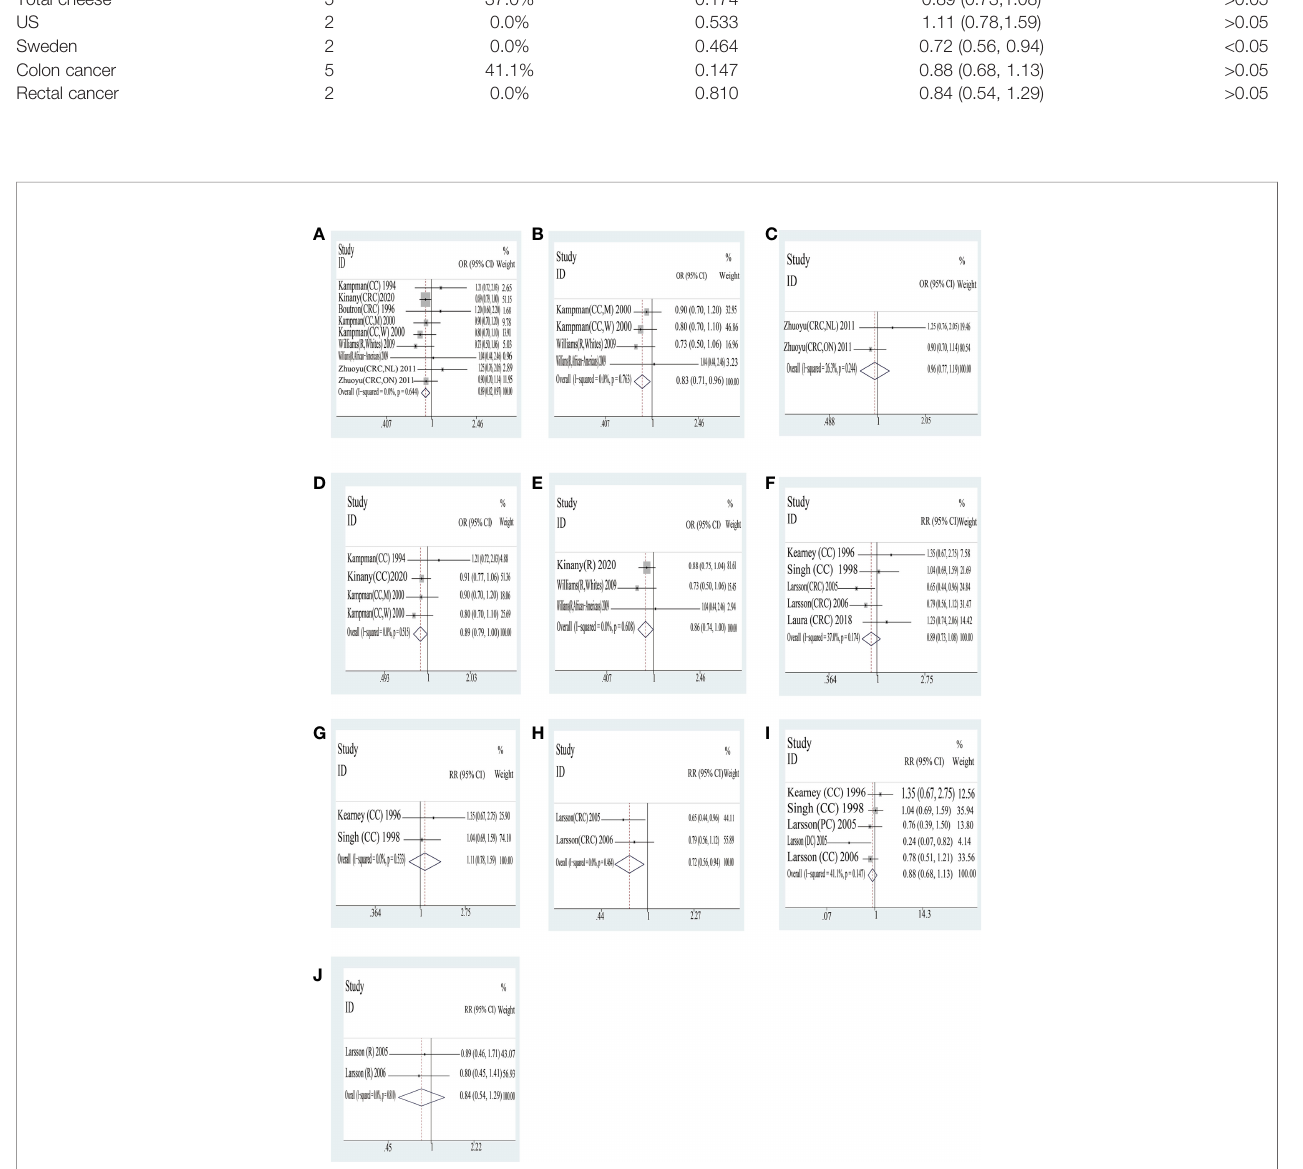
FIGURE 3 | Cheese: forest plot of case – control studies (A – E) and cohort studies (F – J) in yogurt examining the association between consumption of yogurt and risk of colorectal cancer. CRC, colorectal cancer; CC, colon cancer; DC, distal colon cancer; R, rectal cancer; M, man; W, woman; NL, subjects in Newfoundland and Labrador; ON, subjects in Ontario. Case – control studies: (A) total CRC; (B) US; (C) Canada; (D) colon cancer; (E) rectal cancer. Cohort studies: (F) total CRC; (G) US; (H) Sweden; (I) colon cancer; (J) rectal